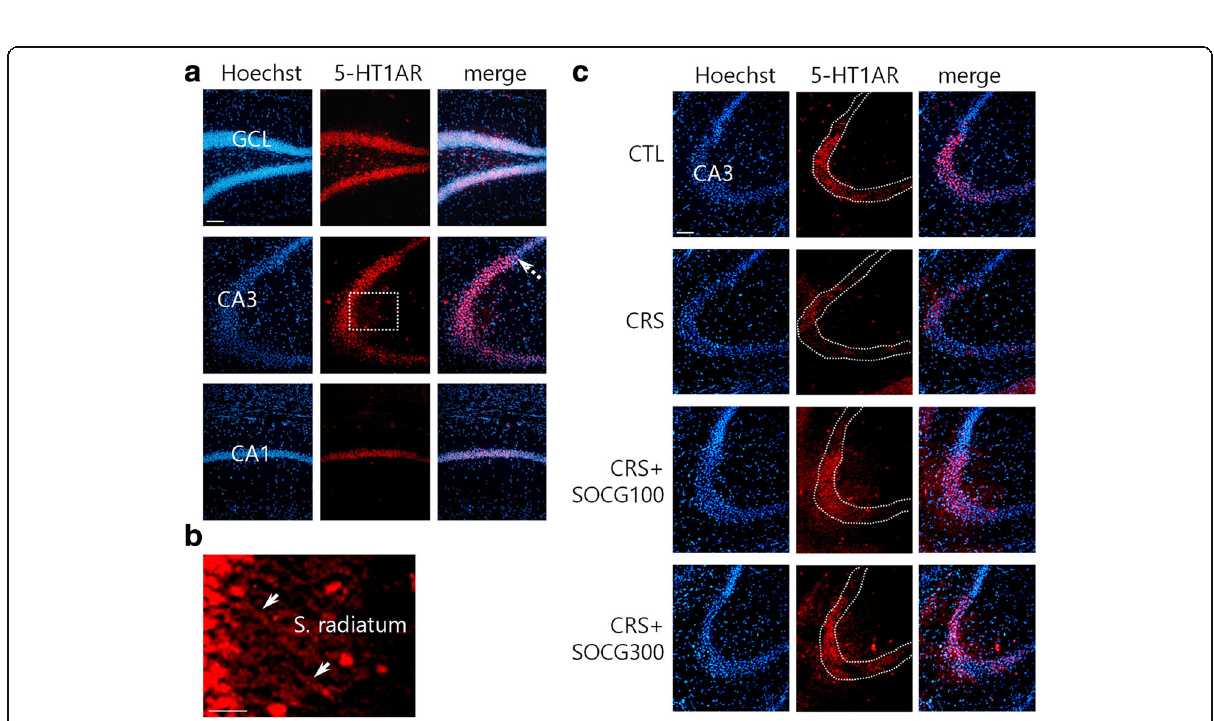
Fig. 2 Immunohistochemical analysis of 5-HT1AR protein signals in the hippocampal subfields. a 5-HT1AR signals in the granule cell layer (GCL), CA3, and CA1 areas. Notice the remarkable decreases of signals at the boundary to CA2 area (marked dotted arrow). b 5-HT1AR signals in the striatum radiatum (Enlarged view for a rectangular area in a ). In ( a ) and ( b ), coronal brain sections from CTL animals were used for immunostaining analysis. c 5-HT1AR signals in the CA3 subfields for different animal groups. Scale bars in ( a ) and ( c ): 200 μ m, bar in ( b ): 100 μ